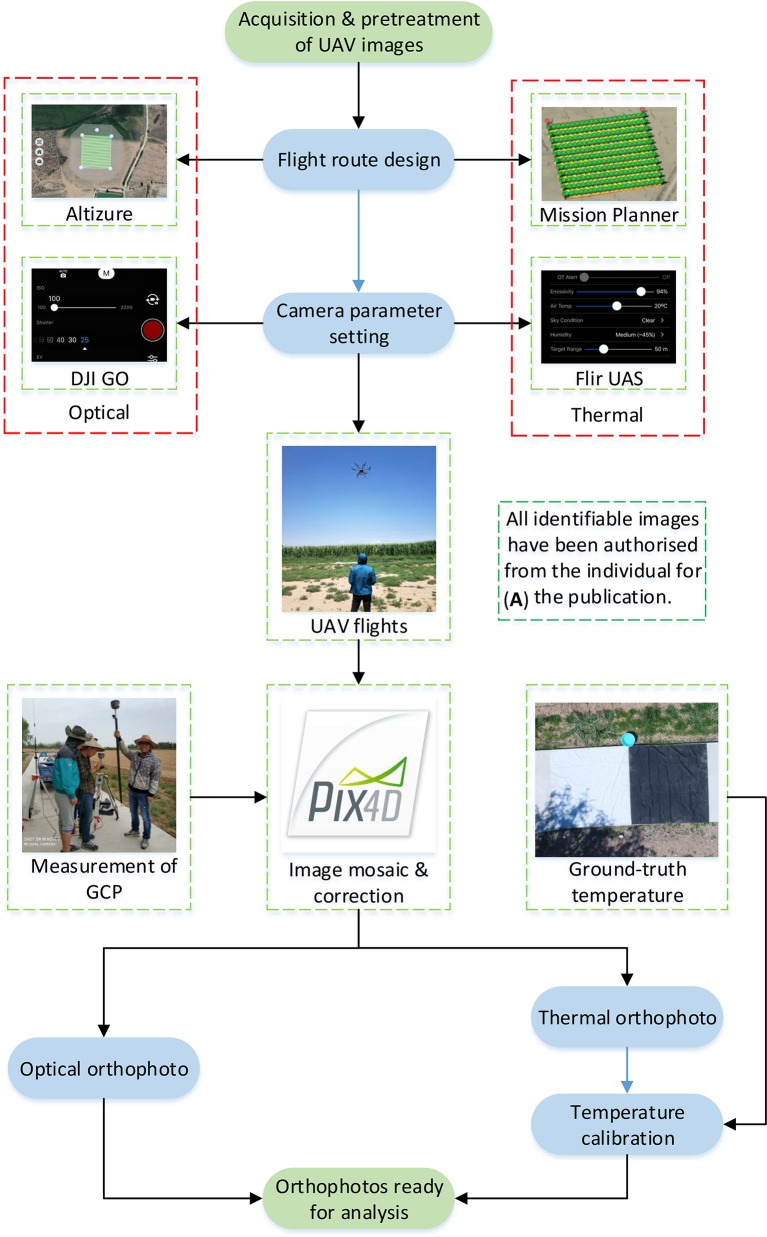
The acquisition and pretreatment of unmanned aerial vehicle (UAV) thermal and red–green–blue (RGB) imagery, including flight route design, camera parameter setting, UAV fights, image mosaicking and correction, and temperature calibration (thermal). (A) Written informed consent of identifiable imagery.